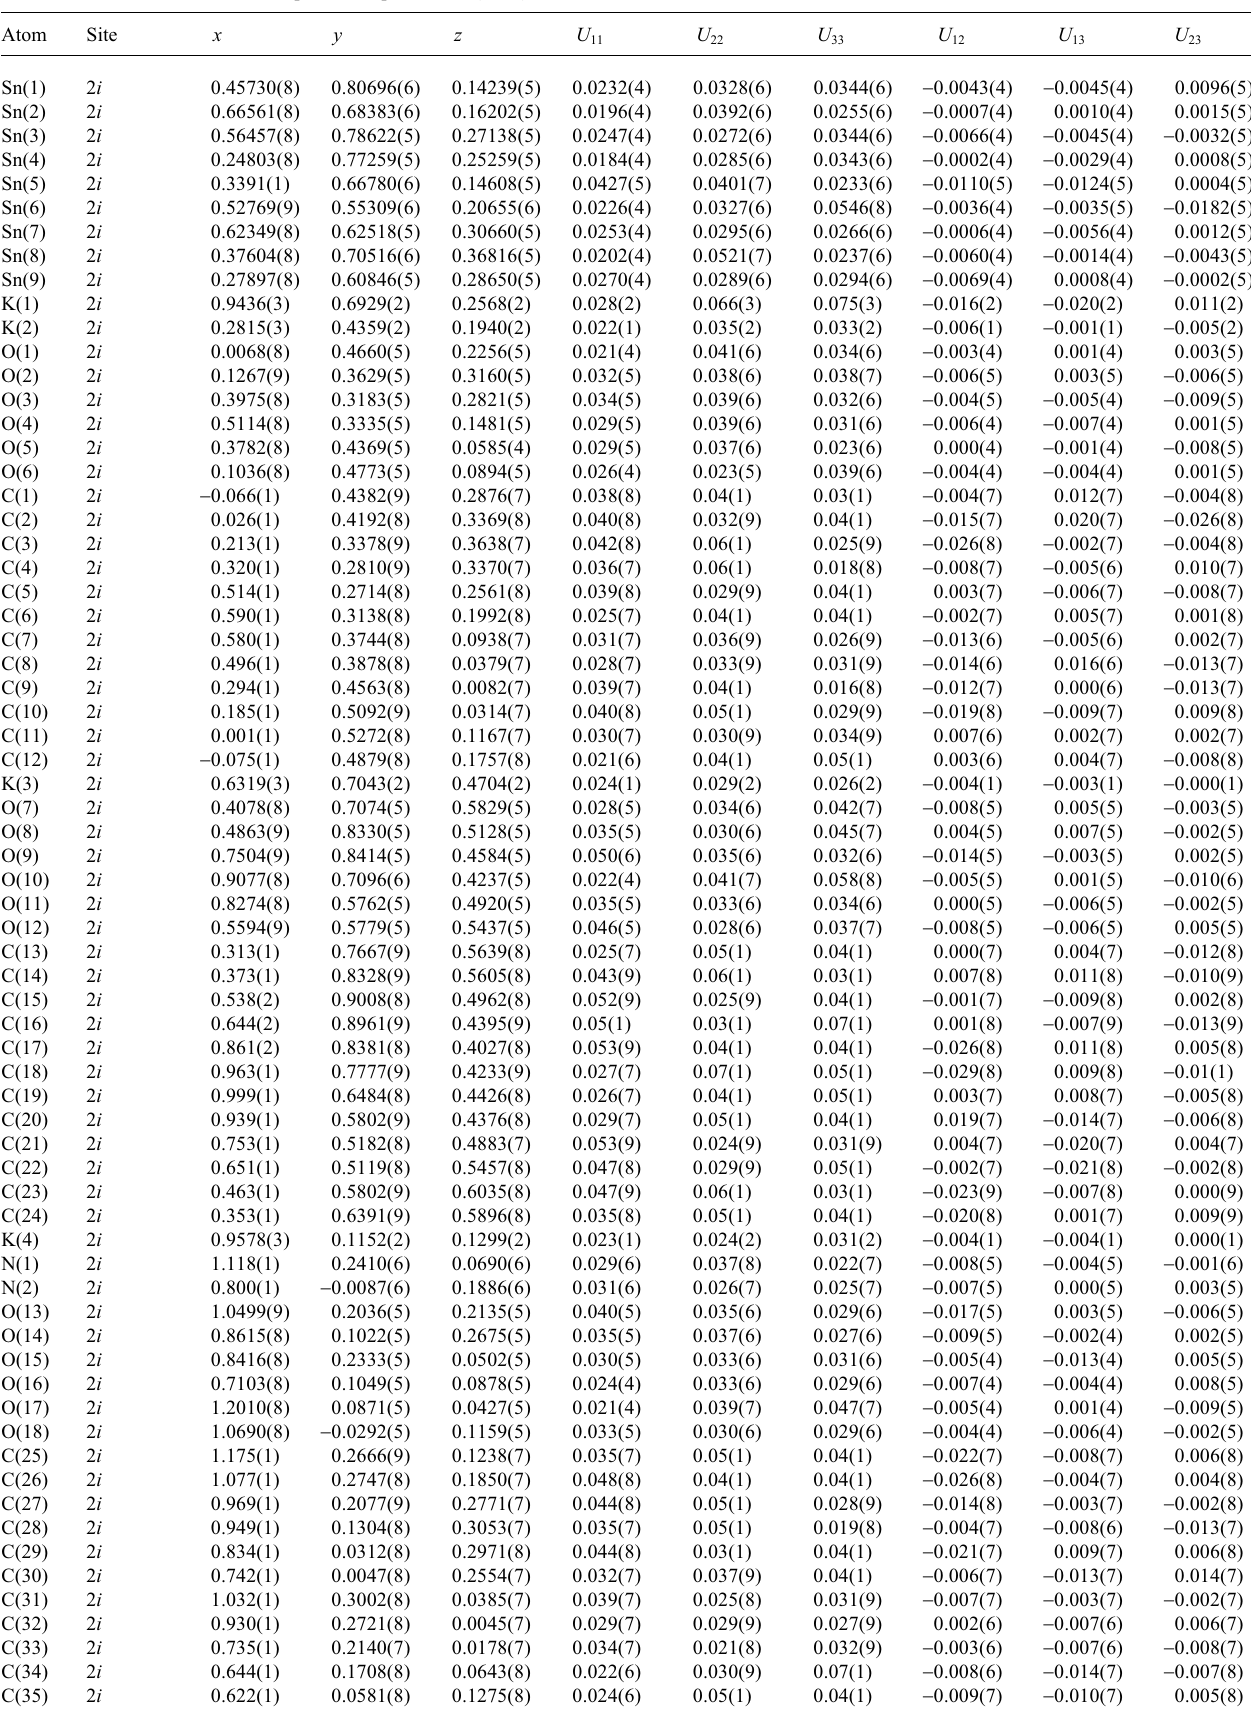
Table 3. Atomic coordinates and displacement parameters (in Å 2 )